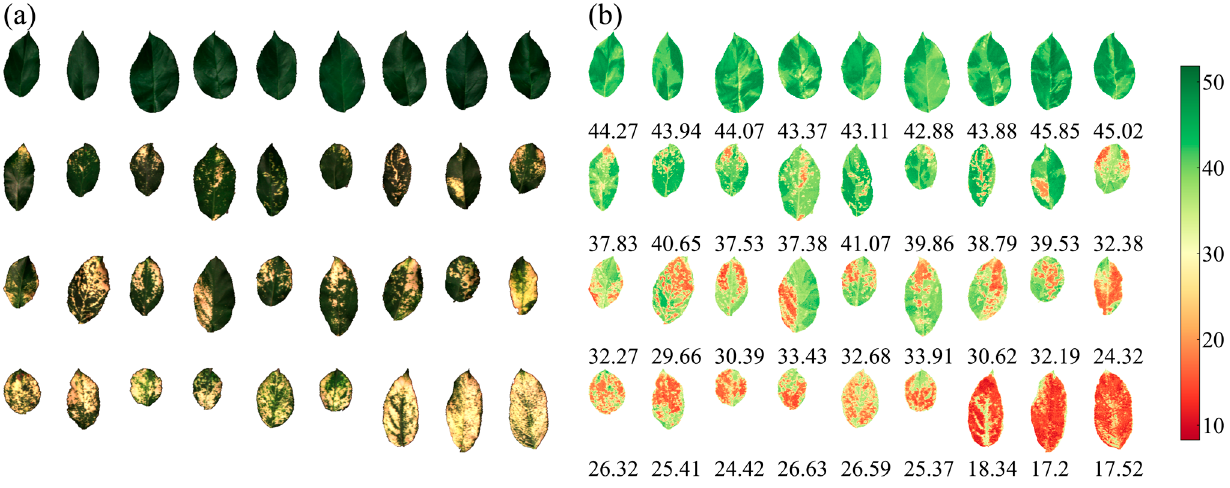
Figure 7. ( a ) Leaf RGB image and ( b ) LCC distribution with average LCC.